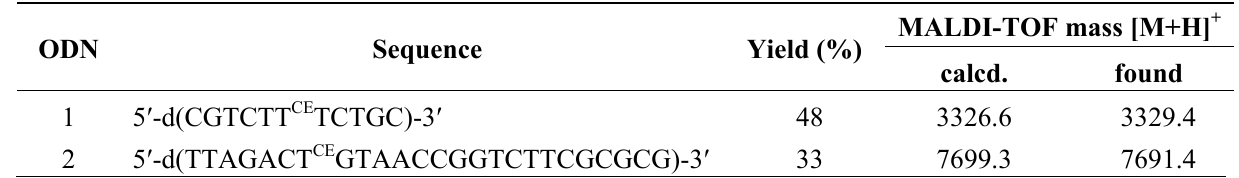
Table 2. Sequences and isolated yields of ODNs containing T CE